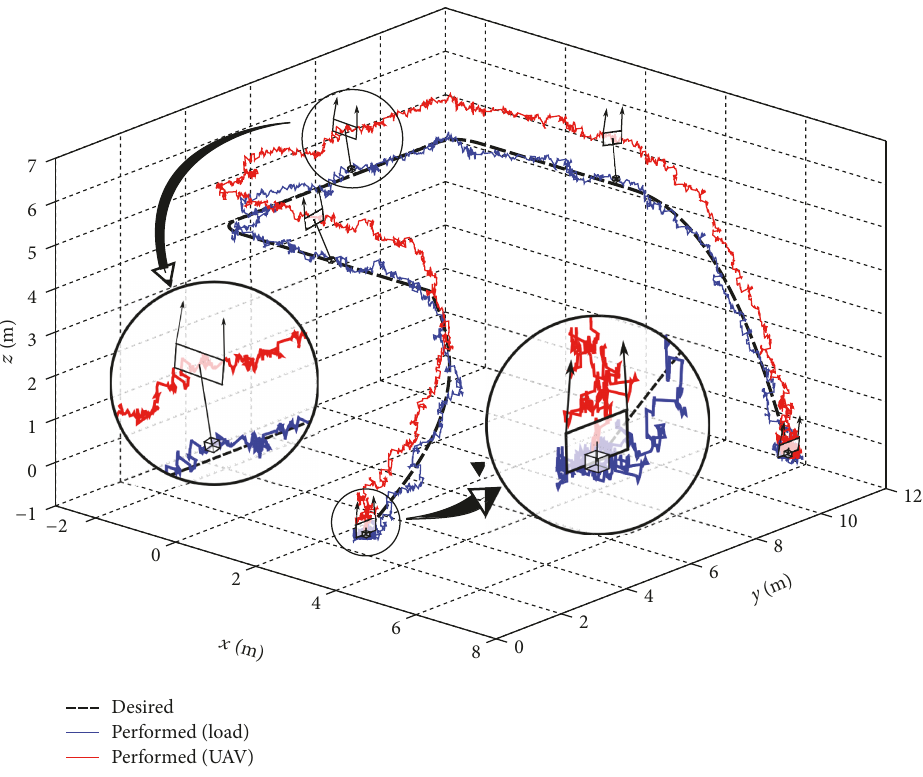
Figure 5: Three-dimensional trajectories of the suspended load (blue), the tilt-rotor UAV (red), and the desired trajectory (dashed black). At the beginning and at the end of the path, the rope’s length is reduced, while throughout the trajectory the rope reaches its maximum value.